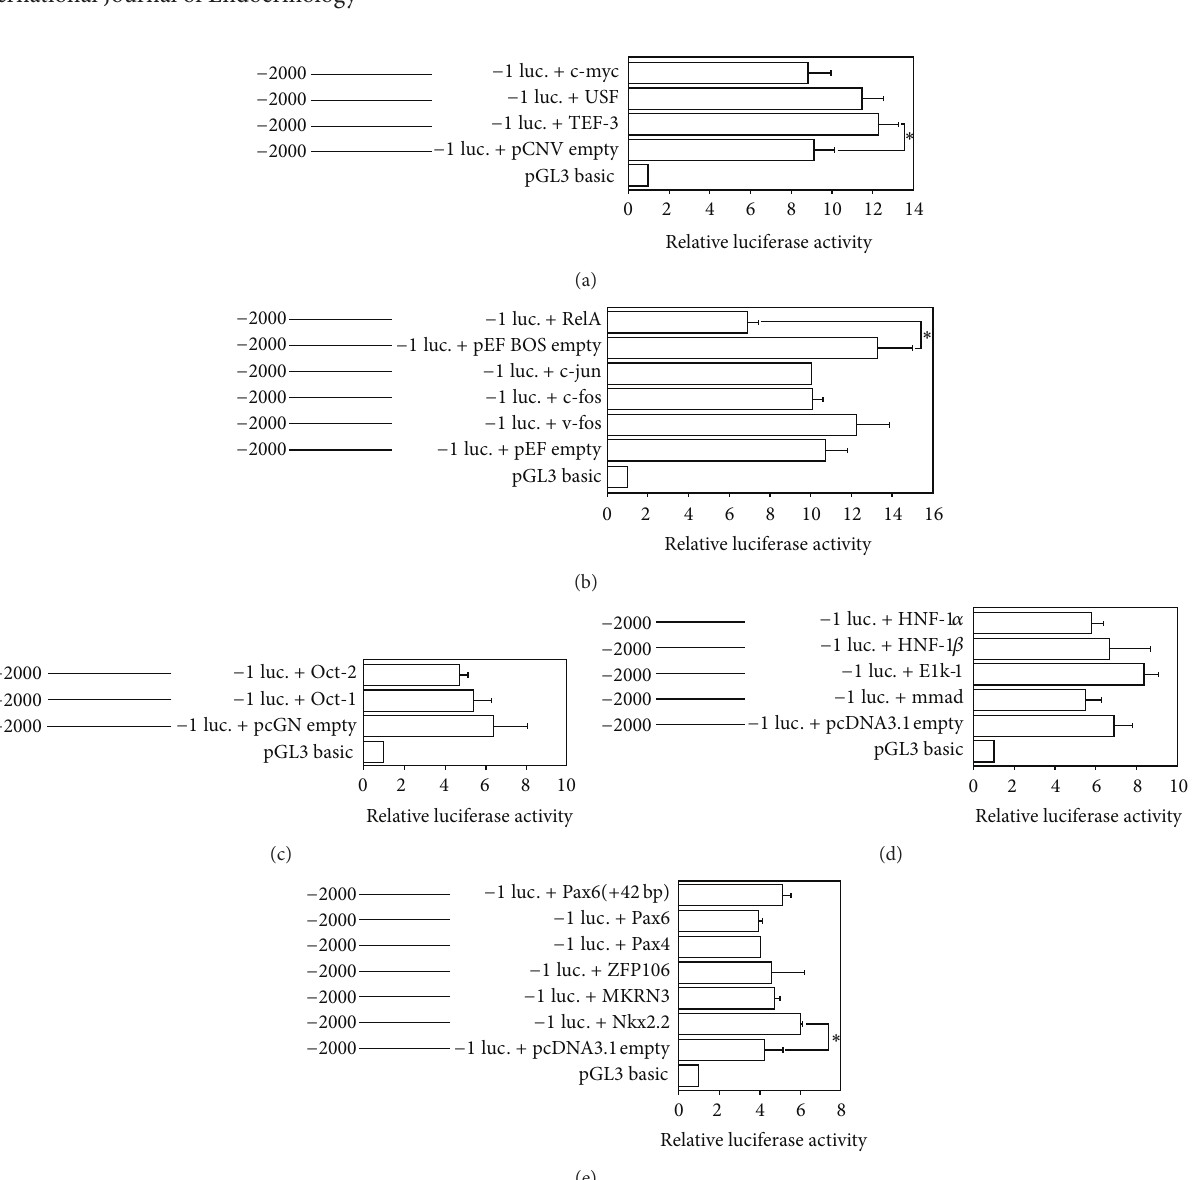
Figure 5: Effects of transcription factors on human ghrelin promoter activity. The vectors used for the experiments are (a) pCNV, (b) pEF- BOS, (c) pcGN, and (d) and (e) pcDNA3.1. The transcription factors are (a) c-myc, USF, and TEF-3, (b) RelA (NF- 𝜅 B (p65)), c-jun, c-fos, and v-fos,(c)Oct-1,Oct-2,(d)HNF-1 𝛼 ,HNF-1 𝛽 ,E1k-1,andmmad,and(e)Nkx2.2,Pax6,Pax4,ZFP106,andMKRN3.Intransfectionexperiments, 2 𝜇 g of the human ghrelin promoter ( − 2000/+1), the firefly luciferase reporter plasmid, and 20ng of pRL-CMV were cotransfected with 25 ng of each transcription factor vector or an empty vector. Promoter activity was normalized by Renilla luciferase activity of the pRL-CMV vector. Relative luciferase activity was expressed as the ratio of luciferase activity cotransfected with each expression vector versus pGL3 basic vector. The data represent the mean ± SE for triplicate samples. Asterisks indicate the differences between each group ( 𝑃 < 0.05